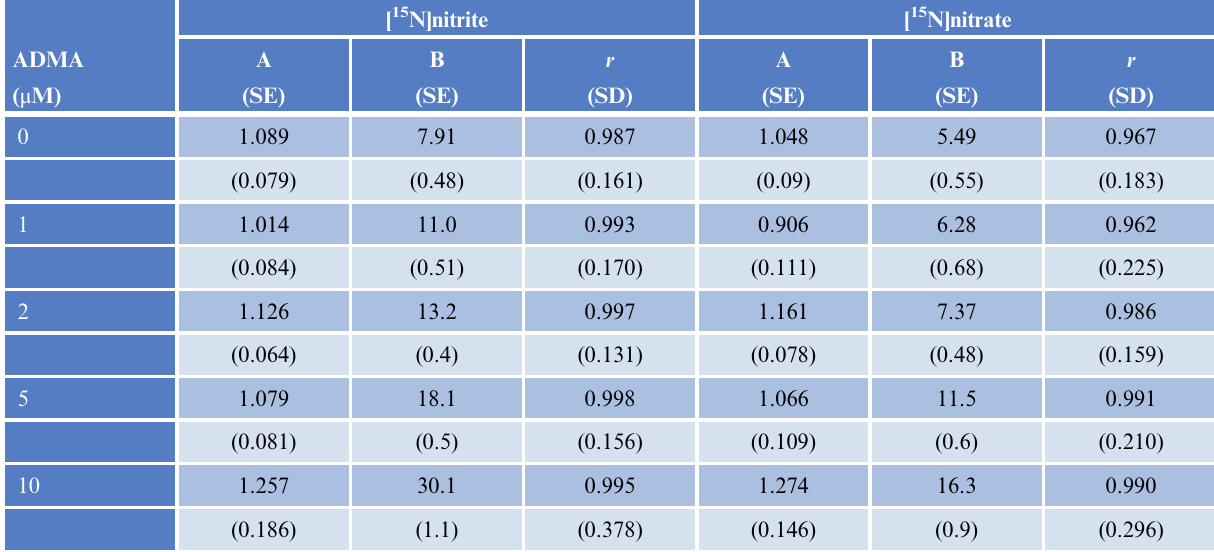
Table 1. Statistical data from primary Lineweaver – Burk plots